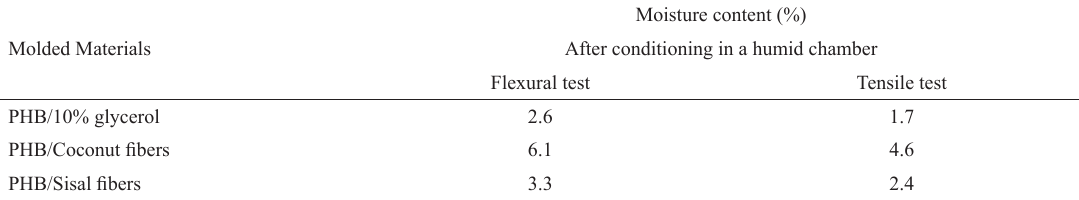
Table 4: Content of moisture from flexural and tensile specimens of PHB without reinforcement and composites with coconut and sisal fibers mats after conditioning in a humid chamber.